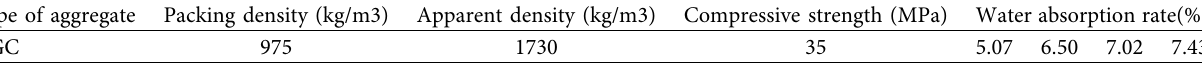
Table 1: Physical characteristics of coal gangue ceramsite (based on GB/T 17431-2010).